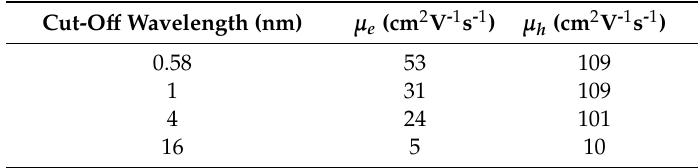
Table 3. Phonon-limited electron and hole mobilities in silicane at room temperature (T = 300 K) for different cut-off wavelengths.